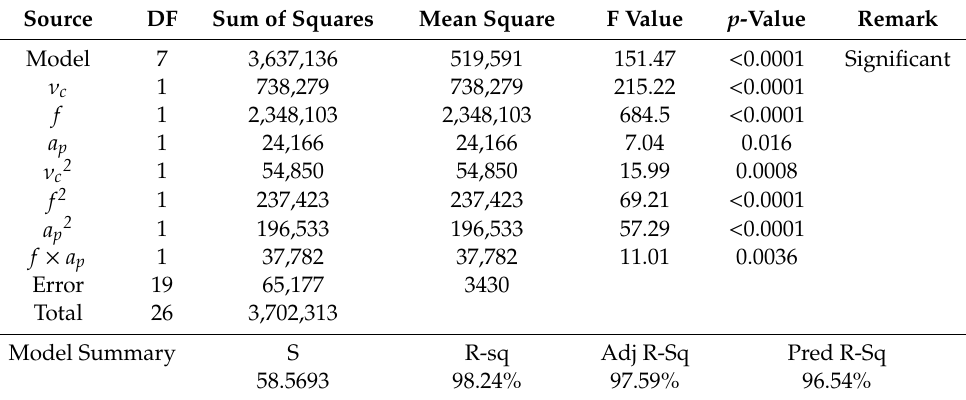
Table 6. ANOVA and R-squared for specific cutting energy ( N s